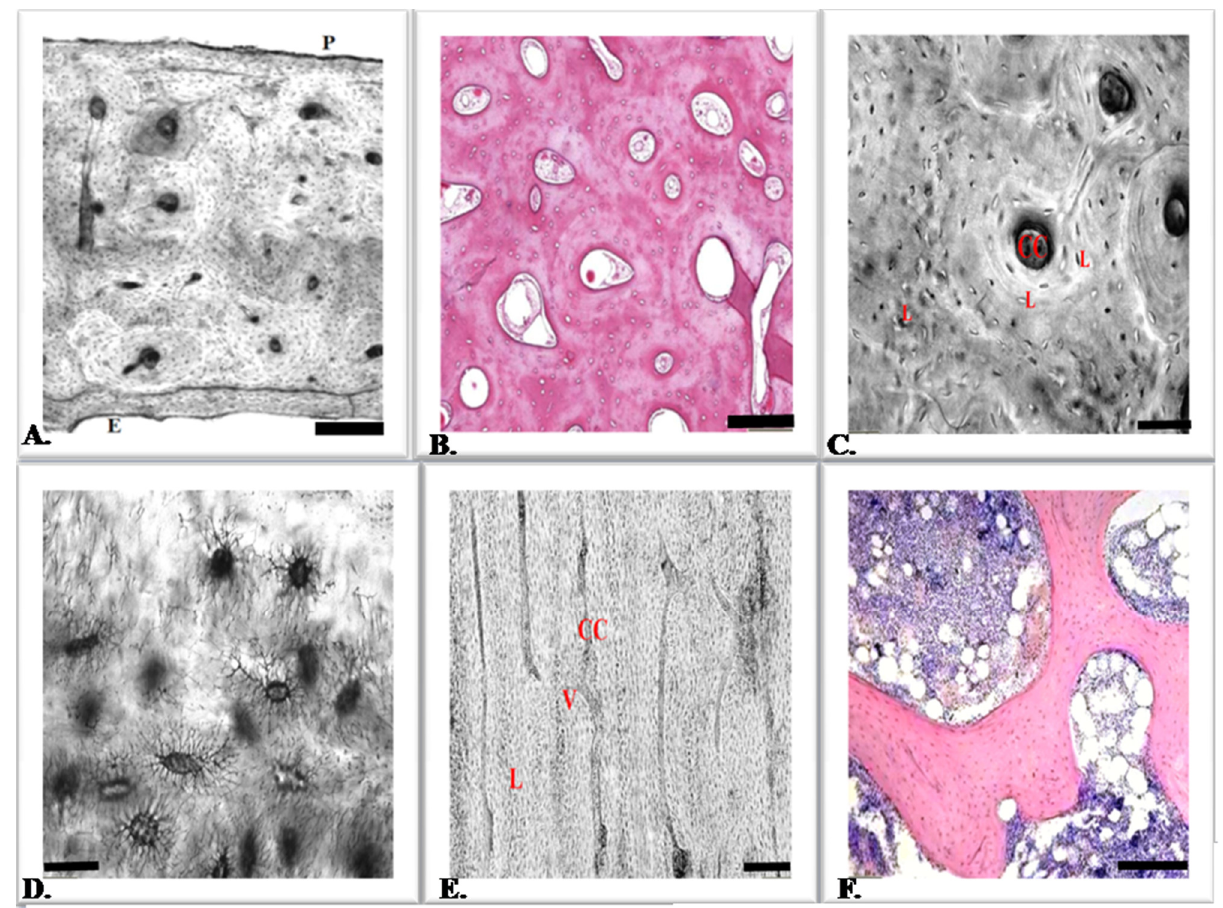
Figure 1. Histological structure of normal bone tissue. ( A ) A cross-section of a properly structured bone showing the compact bone. The photograph of the area of an unstained section of compact bone. Visible osteons with concentric lamellae arranged around central canals (Haversian canal). Externally visible periosteum (P), cancellous bone covered by endosteum (E). Ground bone; scale bar: 2 mm. ( B ) A cross-section of a properly structured bone showing compact bone. Because the osteons are located very close together, compact bone is stronger and harder than spongy bone. Haversian canals contain blood vessels and supply developing bone with essential nutrients. Small trabeculae create a highly porous medullary bone. They provide support, offering considerable strength without significantly increasing the weight of the bone. H & E section; scale bar: 100 µm. ( C ) Osteons are structural and functional units, characteristic of compact bone. An osteon with concentric lamellae (L) surrounding a central canal (CC) is shown. The interstitial lamellae of the osteon are also visible; these are remnants of old osteons; ground bone; scale bar: 10 µm. ( D ) Photomicrograph of osteocytes and their associated processes. Through these long processes, cell-to-cell communication takes place and substances needed by the cells are transferred. Ground bone; scale bar: 5 µm. ( E ) Longitudinal section of the compact bone. Visible Haversian canal (H) connected to the transverse perforating canal (Volkmann) (V). Osteocytes embedded with lamellae (L). Ground bone; scale bar: 200 µm. ( F ) Histological structure of spongy bone. This structure is characteristic of bone marrow. Bone trabeculae surround the bone marrow along with blood vessels, and this arrangement strengthens the spongy bone, making it stronger. H & E section; scale bar: 50 µm.